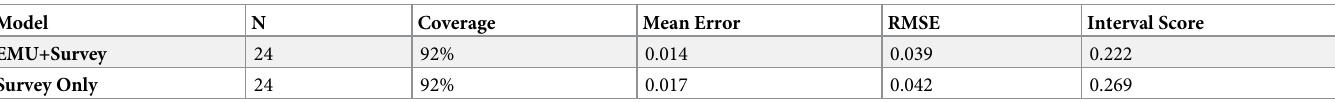
Table 3. Validation results. Summaries of validation results are shown for 24 countries in the test data set. Coverage is defined as the percentage of time that the true value is captured with the 95% uncertainty intervals. The mean error is the average prediction error. RMSE is the Root Mean Squared Error.